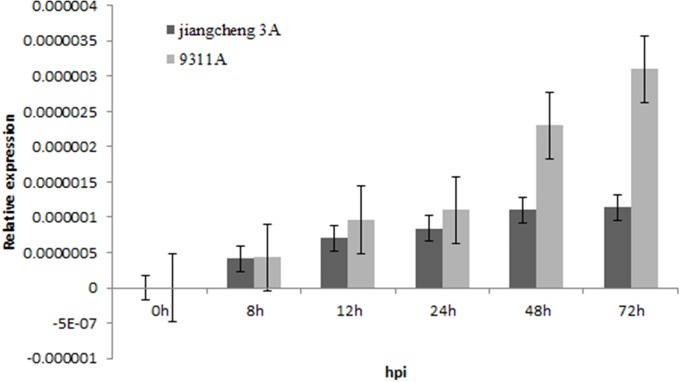
Relative T. horrida fungal abundance determined by qRT-PCR analysis of T. horrida 18S rRNA sequence in samples harvested at 0, 8, 12, 24, 48, and 72h post inoculation.